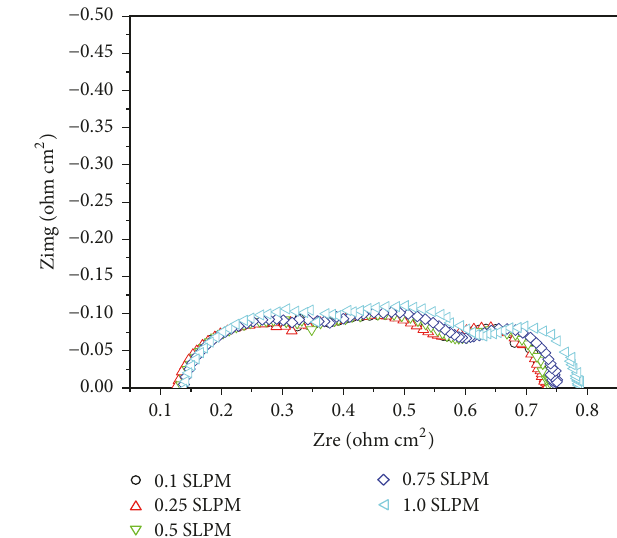
Figure 12: Impedance curves at different air flow rates at 750 ∘